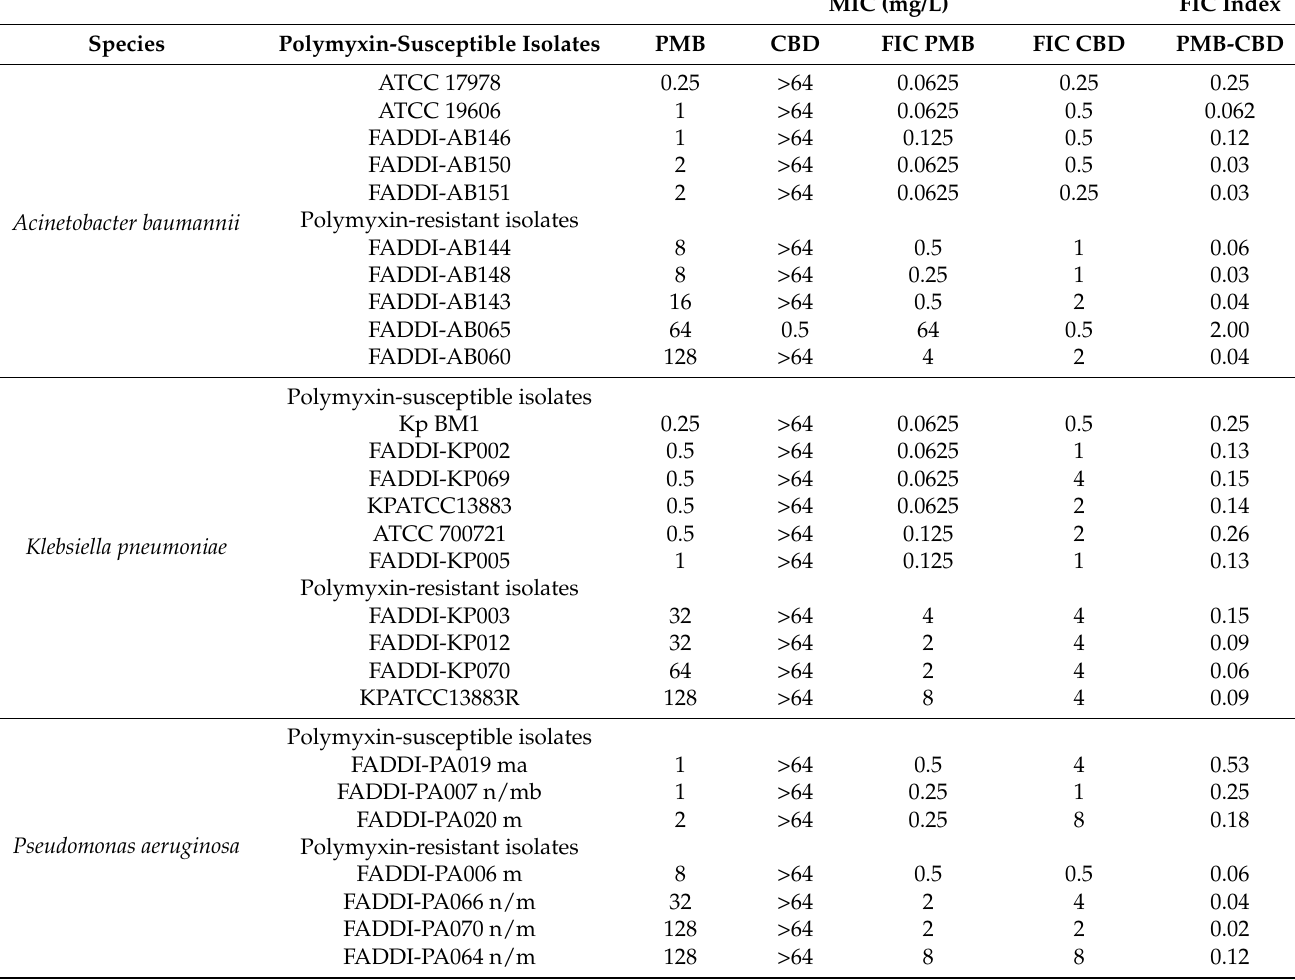
Table 1. Antimicrobial activity of polymyxin B (PMB) and cannabidiol (CBD) in monotherapy and in